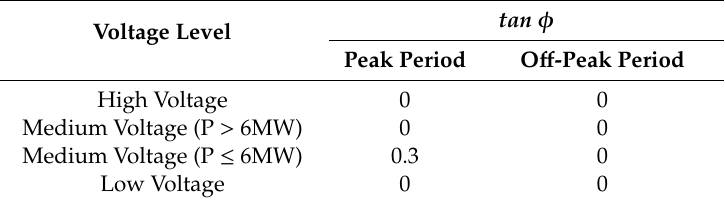
Table 1. Reactive power policy for the special scheme